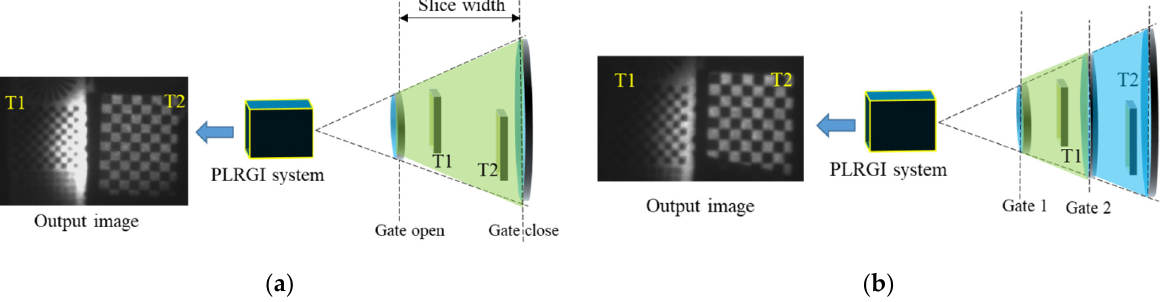
Figure 1. Examples of fixed gate and sliding gate. ( a ) Description of output image from fixed gate; ( b ) Description of output image from sliding gate.